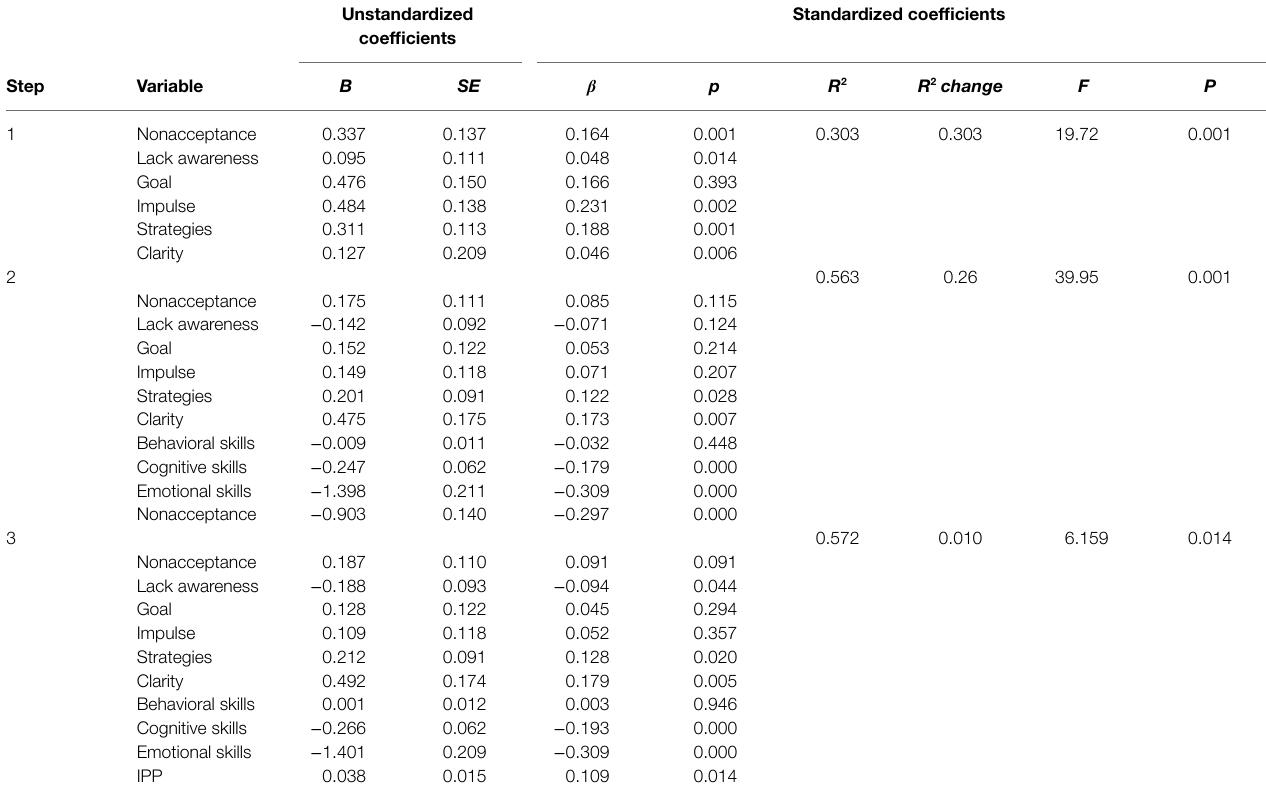
TABLE 3 | Hierarchical regression of SA on DERS, SC, and IPP ( n = 280).